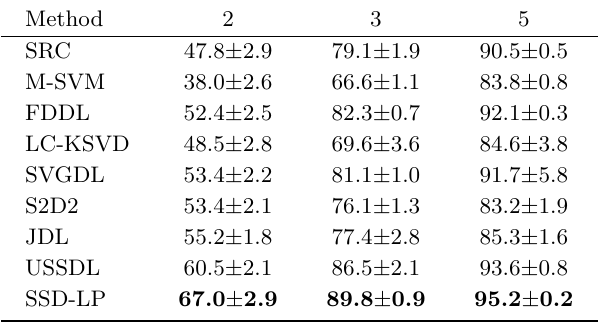
Table 3 Recognition rate for various methods, for digit databases (Unit: %) USPS and MNIST (Unit: